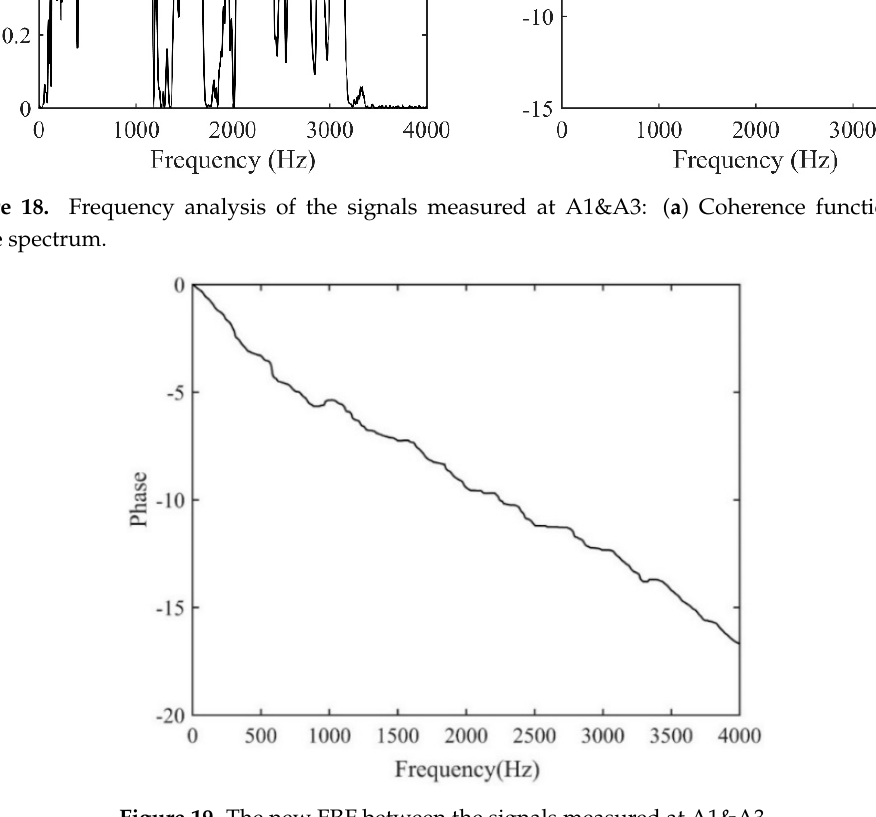
Figure 20. The proposed ADPHAT algorithm for TDE when D = 78.8 m. 5. Conclusions In this paper, an ADPHAT method for TDE has been developed for pipeline leakage detection. It has expanded on the conventional LMS algorithm, and developed a new way to calculate the time delay of the sensor signals. The leakage propagation characteristics of pipelines have been accounted for in the implementation process of the proposed adaptive algorithm, which results in an FRF containing only the phase information of two leak signals. Due to the duality of both the time and frequency domains, the time delay is estimated by searching the maximum value of the inverse FT of the new FRF. Simulations on plastic water pipes demonstrate the effectiveness of the proposed method for locating leaks even in a low SNR environment. Field tests were further conducted to confirm the improved performance compared to the conventional LMS algorithms for TDE, which is particularly well-suited to pipeline leakage detection. An additional advantage of this approach over the existing correlation-based leak detection methods is that it does not rely on the selection of pre- filtering/frequency weighting of input signals, and potentially could interpret the similarity between two sensor signals in a low SNR. Author Contributions: Yan Gao conceived and designed the experiments; Yifan Ma and Yan Gao performed the experiments; Yifan Ma and Yan Gao presented the method; Yifan Ma analysed the data and wrote the article; Yan Gao, Xiwang Cui, Michael J. Brennan, Fabricio C.L. Almeida and Jun Yang contributed to coordinating and revising the article. All authors read and approved the manuscript. Funding : The authors gratefully acknowledge the support of the National Natural Science Foundation of China (under Grant 11774378). Conflicts of Interest: The authors declare no conflict of interest.